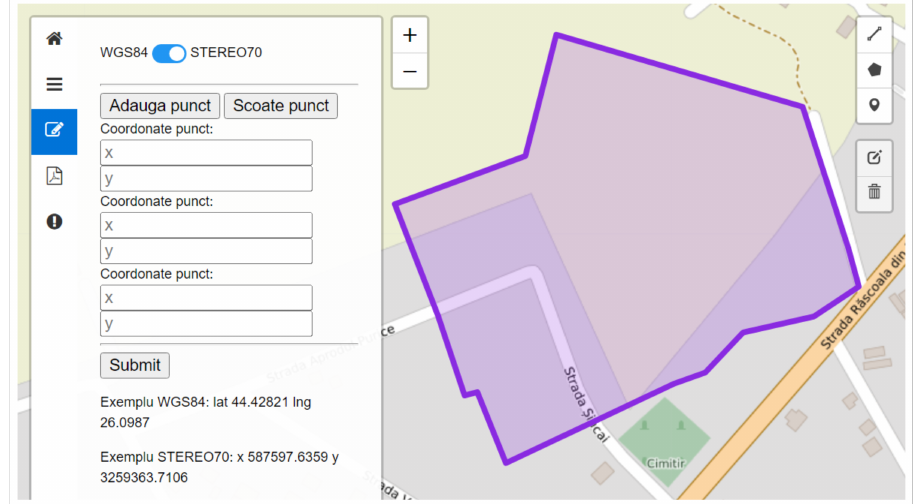
Figure 21. User graphical interface to input coordinates in Stereo70 format and map representation. The validated archeological site represented in purple